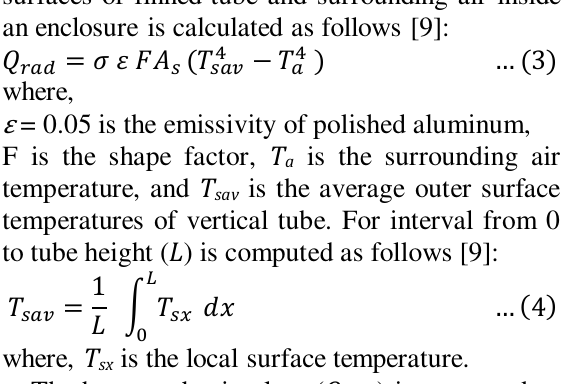
Fig. 3. Schematic diagram of front-section for vertical externally-finned tube assembly with thermocouples